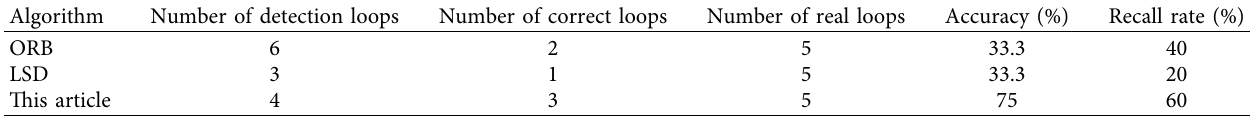
Table 1: Analysis of the detection results of three algorithms.